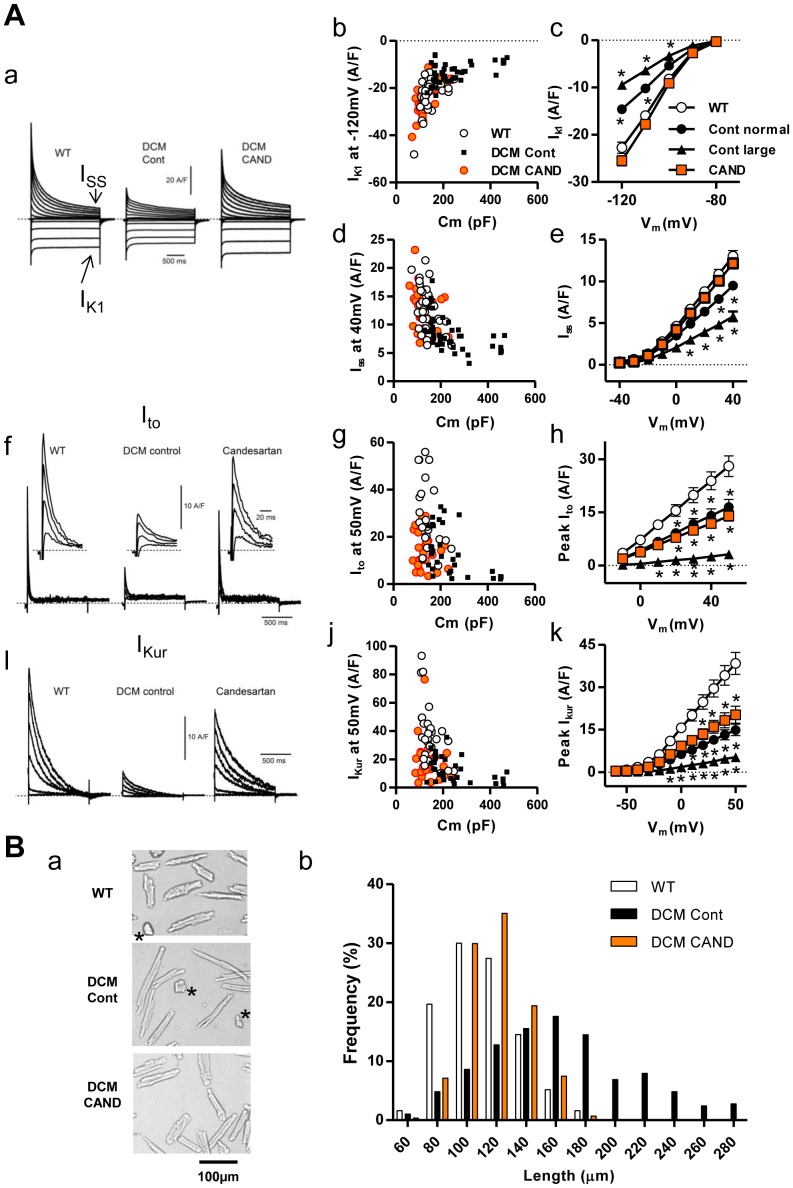
Whole-cell currents of major K+ channels which contribute to repolarization and the size distribution of ventricular myocytes.
A.
 IK1, Iss Ito, IKur of WT, control and candesartan-treated DCM cells. a. Representative current traces of whole cell currents activated by voltage steps (2 s, −120 to +40 mV in 10 mV increments) from a holding potential of −80 mV. IK1 and Iss were measured as the steady-state amplitude of the whole-cell current at pulse end. b and d, IK1 and Iss in individual cells at the largest voltage step (−120 mV and +40 mV, respectively) were plotted against their Cm, which reflects the cell surface area. c and e. Current-voltage (IV) relations of IK1 and ISS, respectively. f
. Representative current traces of Ito activated at −10, +10, +30, and +50 mV (insets expand the peaks on a fast time-base). g.
 Ito in individual cells at the largest voltage step, 50 mV. h. IV relations of Ito. i. Representative current traces of IKur activated at −50, −30, −10, +10, +30, and +50 mV. j.
 IKur in individual cells at the voltage step of 50 mV. k. IV relations of IKur. b, d, g and j: WT (open circle, n = 25–34 from six hearts), Cont (filled square, n = 33–43 from eight hearts), CAND (orange circle, n = 26–36 from five hearts). c, e, h and k: WT (open circle, n = 25–34), normal-Cm control DCM (Cm<250 pF, filled triangle, n = 14–23), large-Cm control DCM, (300 pF<Cm<500 pF, filled circle, n = 6–8), candesartan-treated DCM (orange square, n = 26–36), Dotted lines: zero-current level. *P<0.001 vs WT. B
. Length distributions of ventricular myocytes. a. Typical pictures of myocytes obtained with 10× objective lens. Images at higher magnifications were shown in Figure S4 in File S1. *Cells showing contracture, which were discernable from shrunken shape and shortened sarcomere length, were excluded from analysis. b. Histogram of longitudinal length of ventricular myocytes for WT (n = 310 from five heart), Cont (n = 290 from six heart) and CAND (n = 294 from five hearts).